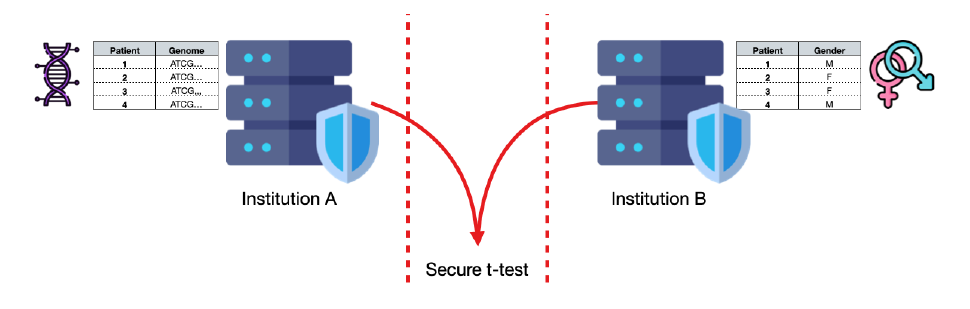
Figure 2. Federated setting for Welch’s t -test. Institution A owns the genomic data, and institution B owns the phenotype data, on the same set of patient IDs. They jointly do the federated t -test without revealing any private data information to each